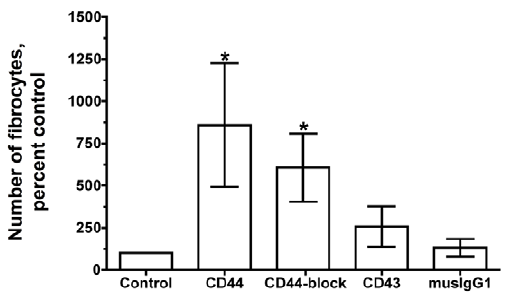
Figure 8. Anti-CD44 antibodies potentiate the differentiation of monocytes to fibrocytes. Human PBMC were cultured in 2 m g/ml anti-human anti-CD44, anti-CD43, or mouse IgG1 isotype control. After 5 days, the cells were air dried, fixed, stained, and the number of fibrocytes was counted. The results are mean 6 SEM of percent control (n=6 separate experiments). The number of fibrocytes per 2.5 6 10 5 PBMC in controls was 350, 50, 350, 250, 450, and 50. * indicates p , 0.05 compared to control, as determined by ANOVA with Dunnett’s post- test). Using the Mann Whitney two-tailed t-test, 2 m g/ml anti-human anti-CD44 antibodies significantly increases the number of fibrocytes when compared to control with p , 0.001. doi:10.1371/journal.pone.0026078.g008 1 b (MIP-1 b ), and monocyte chemoattractant protein-1 (MCP-1) [25,32,72,73]. In cultured macrophages, HMWHA (4.6 6 10 5 – 2.8 6 10 6 Da) inhibited phagocytosis, while LMWHA (9.0 6 10 4 Da) enhanced phagocytosis [71]. The inhibition of macro-